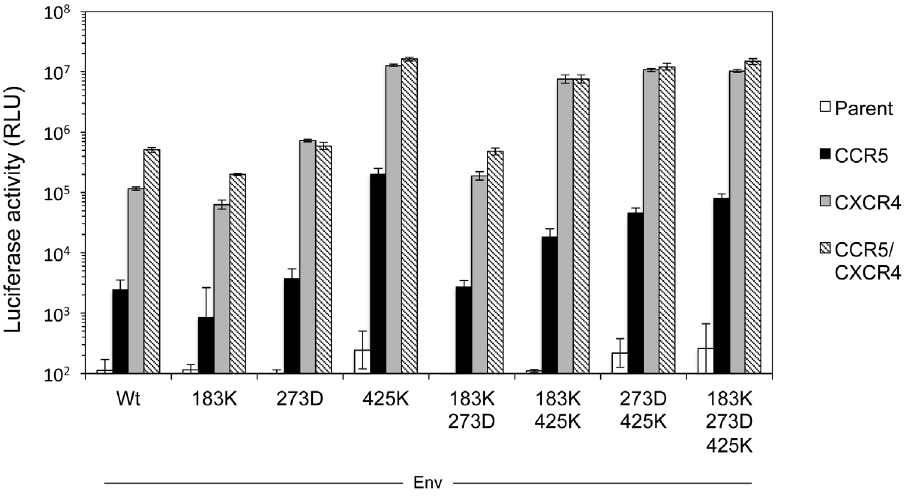
Figure 5. Coreceptor usage and entry efficiency of recombinant pseudotyped HIV. Coreceptor usage of the recombinant luciferase- reporter HIV was determined using NP2/CD4 cells expressing either CCR5 or CXCR4. Entry efficiencies of recombinant pseudotyped HIVs were determined using NP2/CD4 cells expressing both CXCR4 and CCR5. The cells were infected with the same amount of luciferase-reporter pseudotyped virus (10 ng p24Ag) with the indicated mutations. Luciferase activities were measured at 48 h post-infection. Data are the geometric means 6 SD of triplicate experiments.